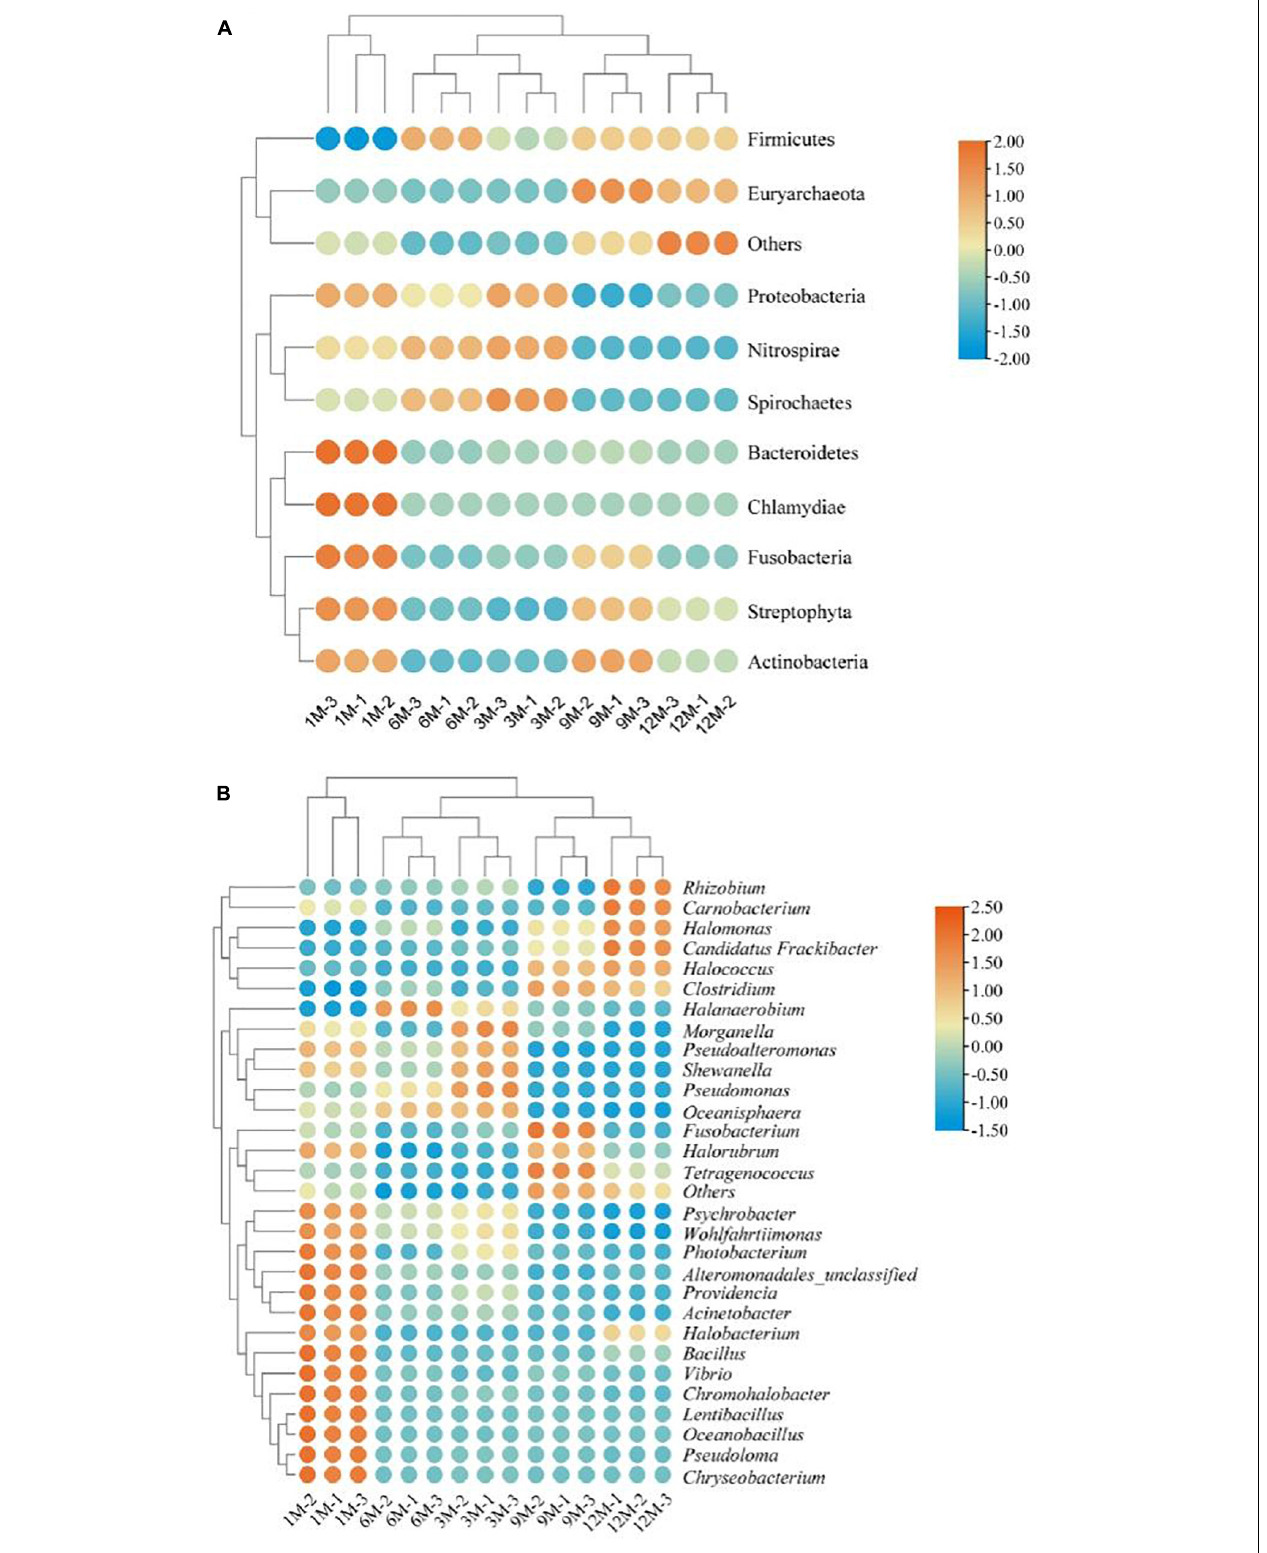
FIGURE 4 | Protein-based taxonomic profiles of traditional fish sauce samples associated with fermentation time at the phylum level (A) and the genus level (B) .